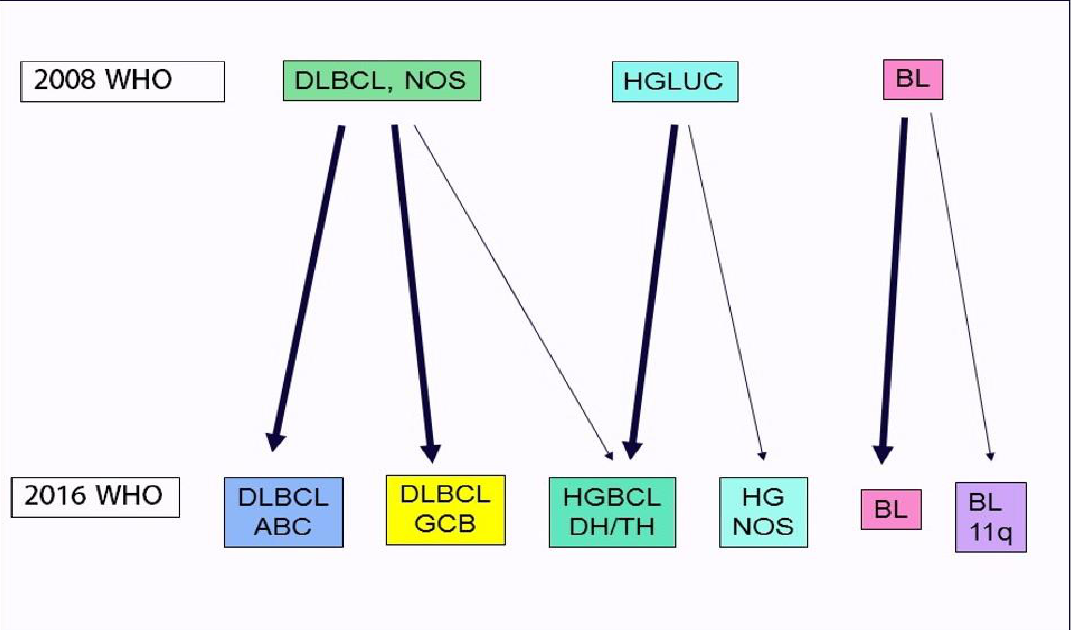
Figure 5. Aggressive B-cell lymphomas. Modified and adapted from Swerdlow et al. [3].